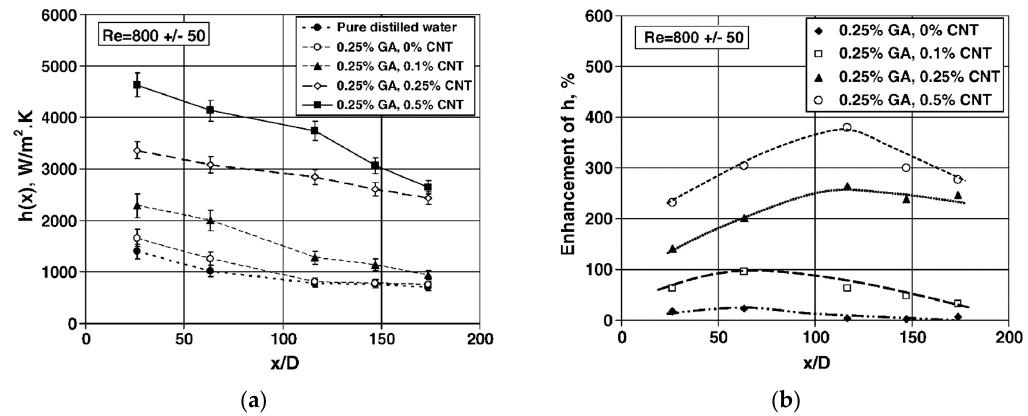
Figure 2. Viscosity of axial profiles of heat transfer ( a ) coefficient and enhancement of heat transfer coefficient ( b ); for different CNT concentrations (pH = ~6) [50].